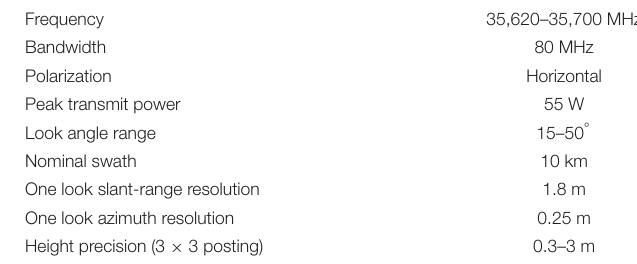
TABLE 1 | Summary of key GLISTIN-A operating